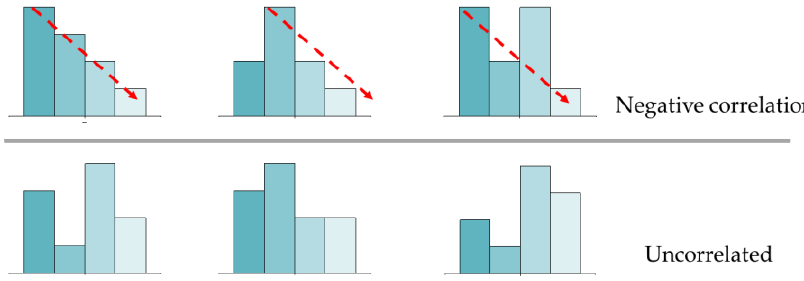
Figure 15. Several possibilities for determining the correlation.